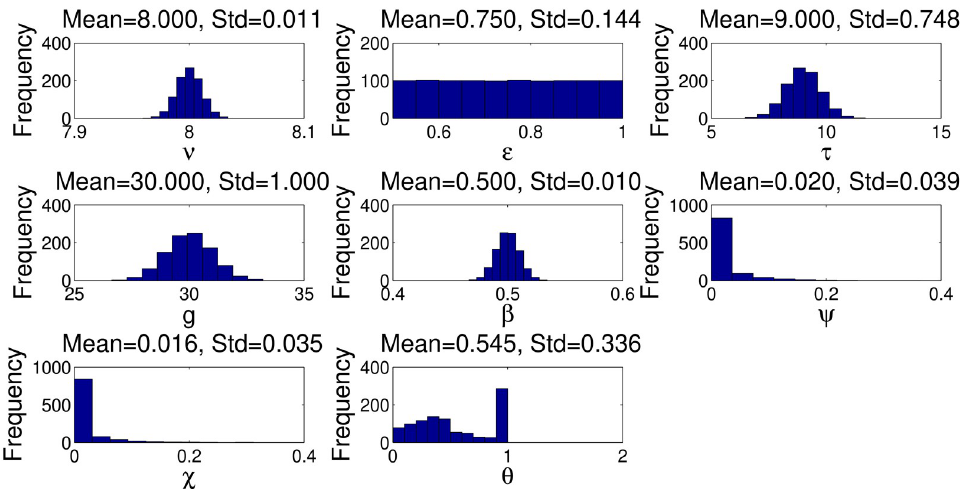
Fig 3. The uncertainty output for all input parameters, together with uncertainty output of the extinction probability, obtained from Latin hypercube sampling using a sample size of 1000 for the seven input parameters. (A). β is the probability deposited larva is female, � probability female is inseminated by a fertile male, g the pupal duration and ν time from female emergence to first ovulation. (B). τ is the inter-larval period, χ the daily mortality rate for female pupae, ψ is the daily mortality rate for females and θ the extinction